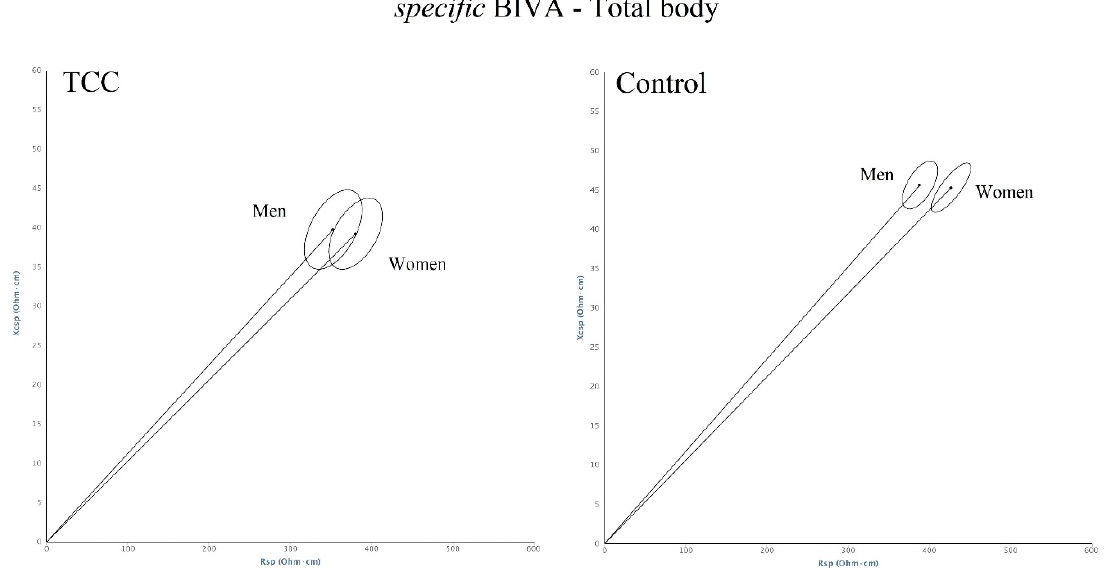
Figure 4. Total body confidence ellipses. Comparison between sexes. TCC: T 2 = 3, 8, p = 0.177; controls: T 2 = 20.1, p = 0.000.